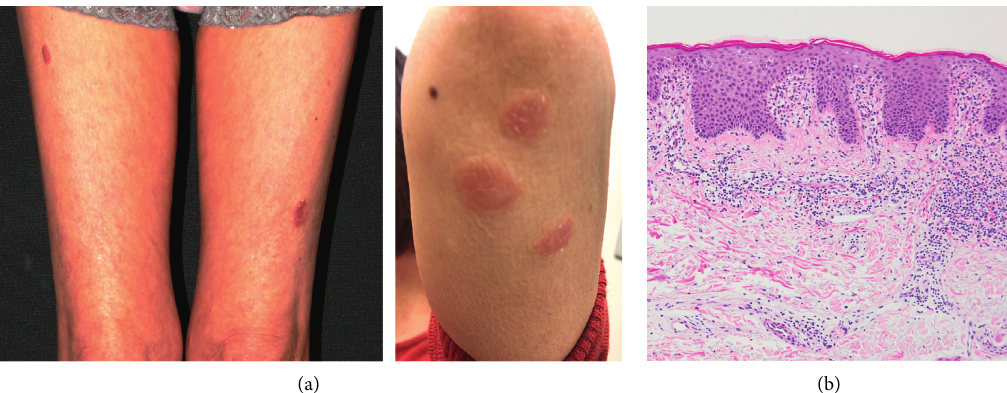
Figure 1: Skin lesion in patient 1. (a) Gross inspection reveals psoriasis-like erythematous lesion on the thighs and left arm. (b) Histological findings show elongated rete ridges, parakeratosis, and mononuclear cell infiltration around dermal vessels (H&E stain ×